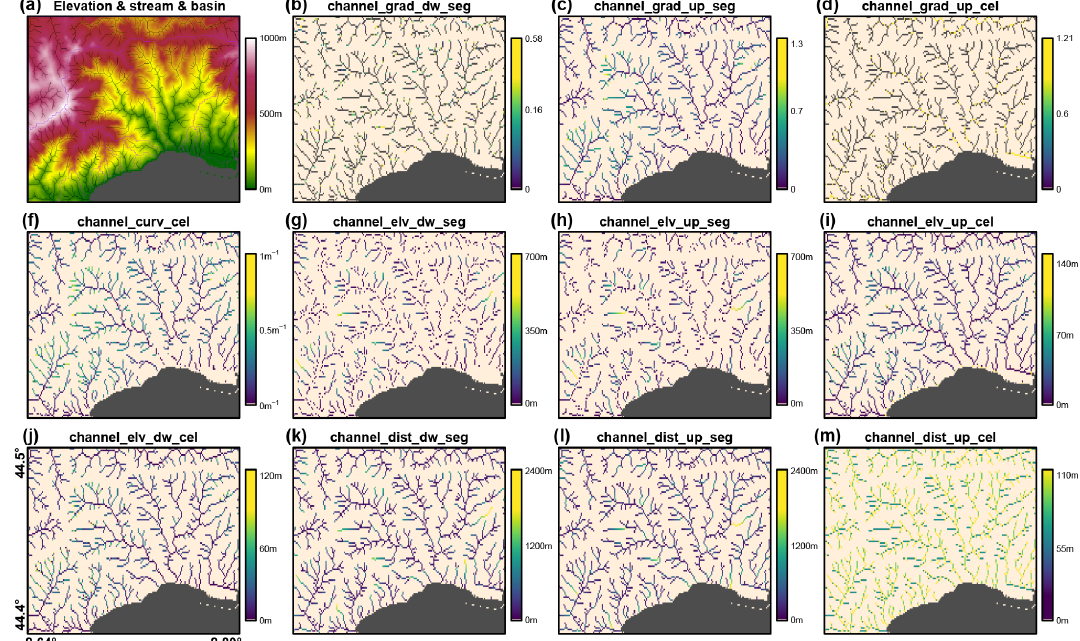
Figure 13. Map (a) shows the stream channels and drainage basins derived from the elevation layer. Maps (b) – (m) show, for the same area, the curvature, gradient (elevation difference divided by distance), and elevation change raster maps computed with r.stream.channel GRASS GIS module. The panel letters correspond to those in Table